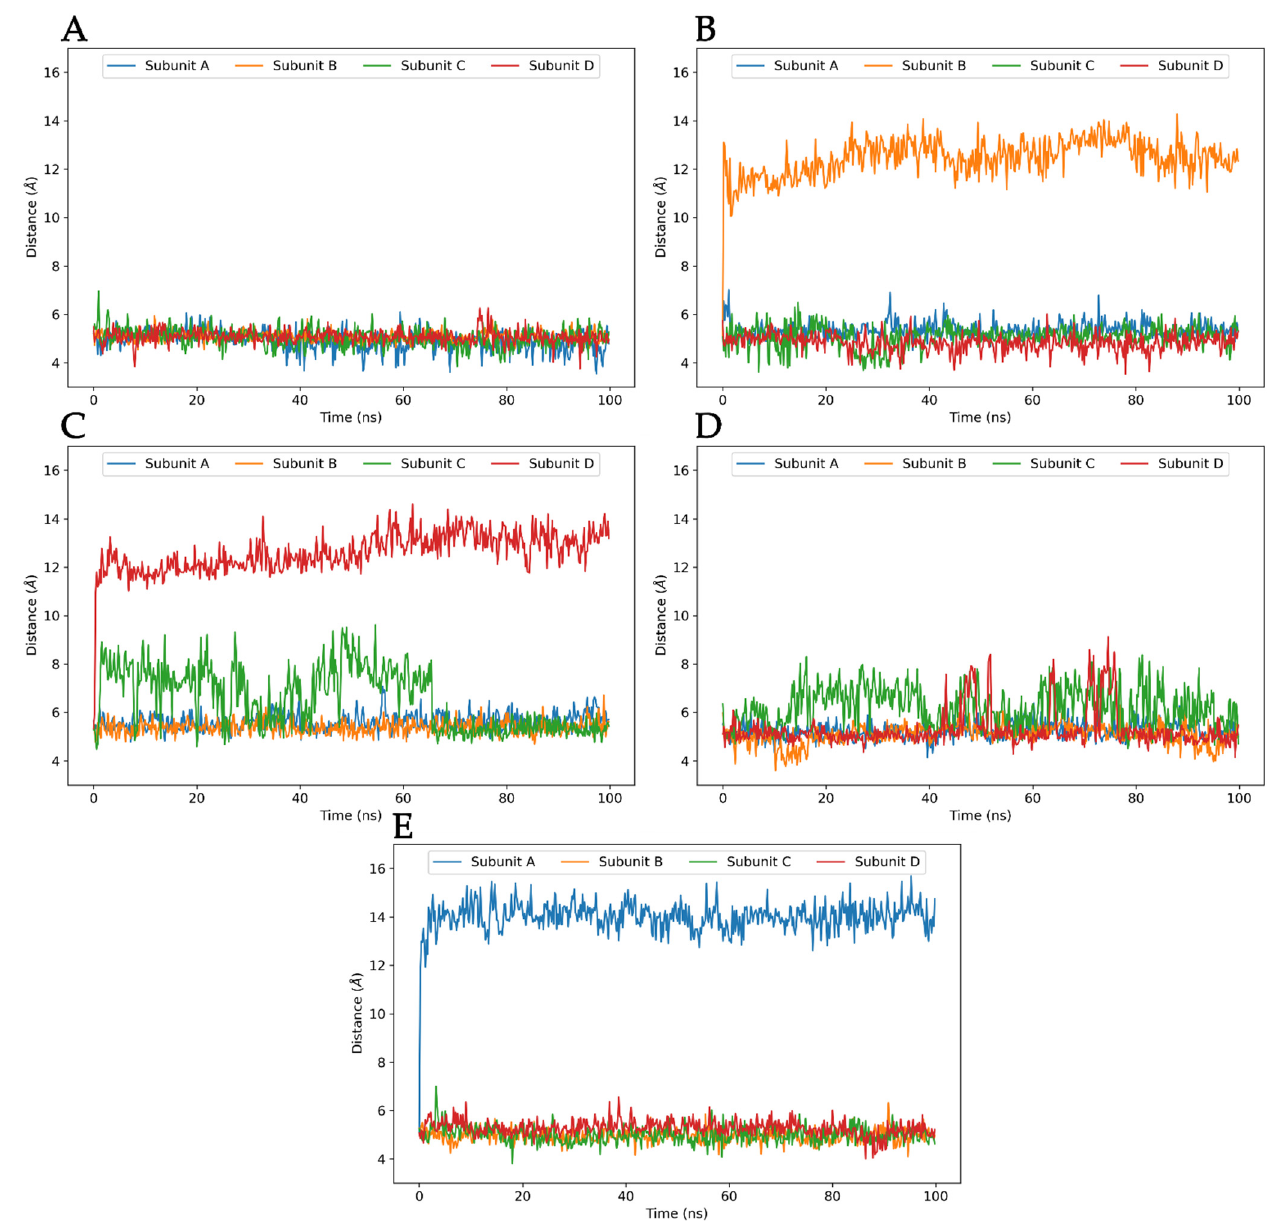
Figure 10. Distances between the aromatic rings of residues F359 and F468 of each subunit in the central cavity obtained by molecular dynamics simulations of astemizole ( A ), clofilium ( B ), imipramine ( C ), MK-499 ( D ), and quinidine ( E ) in complex with the homology model of the K V 10.1. The distances increase for clofilium, imipramine, and quinidine, due to the rotation of F468 in the central cavity.